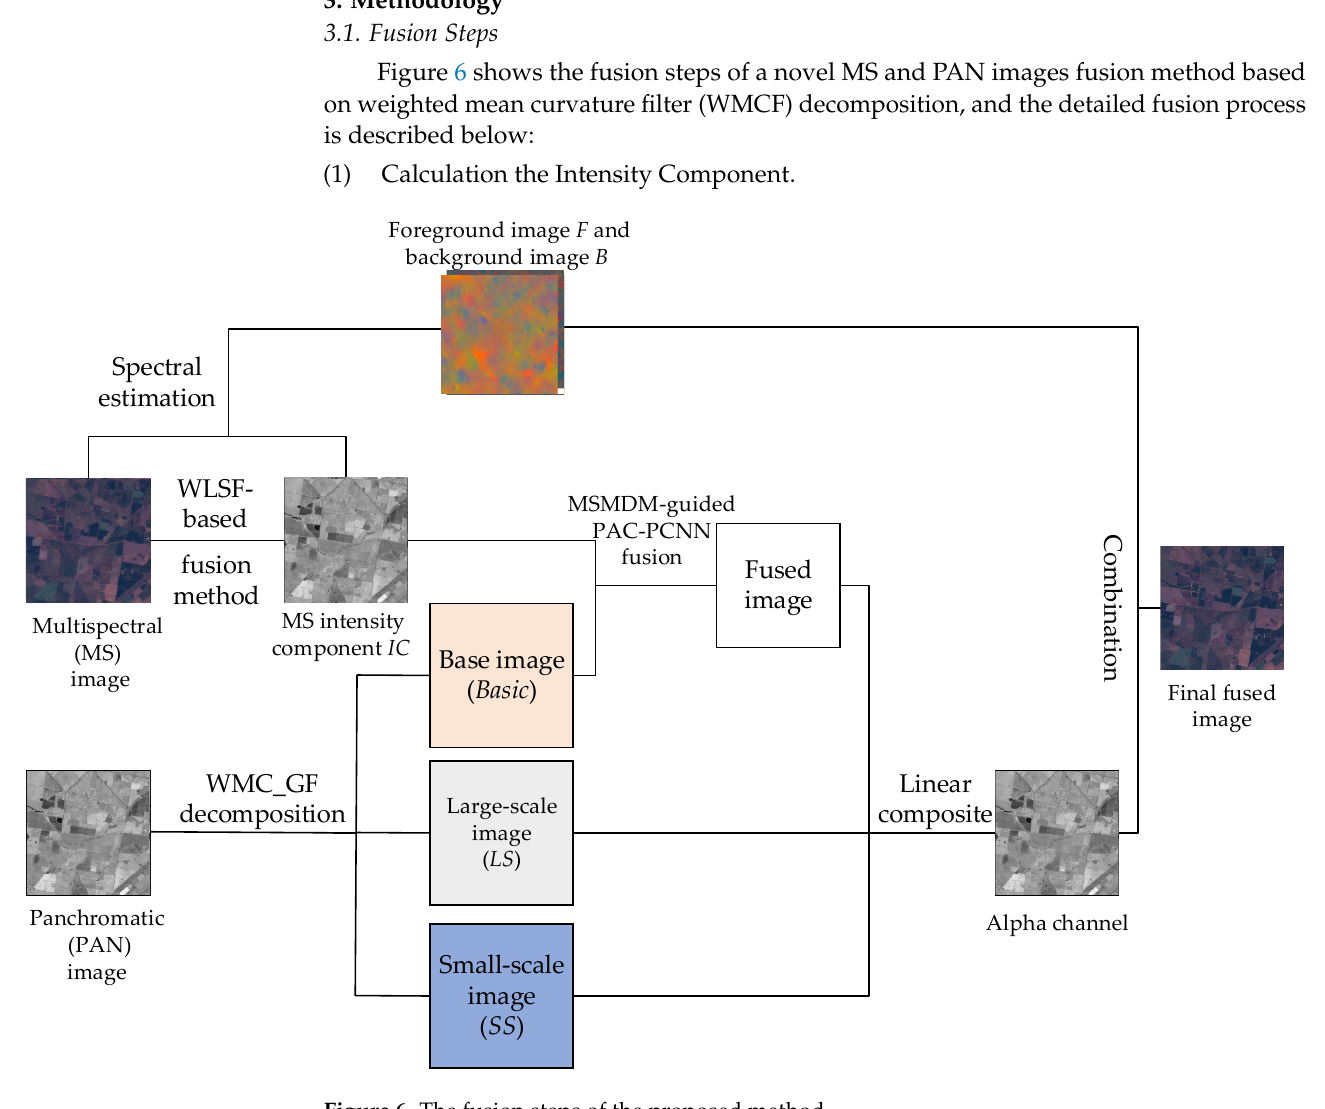
Algorithm 1: A WMCF-based pan-sharpening method